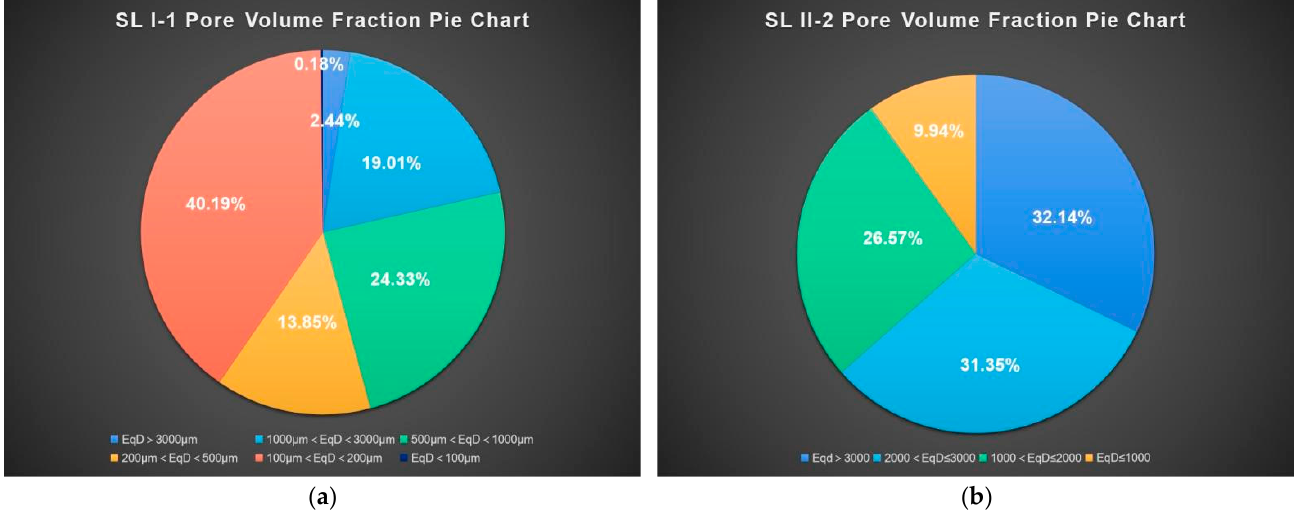
Figure 8. Pie chart of the pore volume fraction of the cement sheath scanned by CT: ( a ) SL I-1; ( b ) SL II-2.